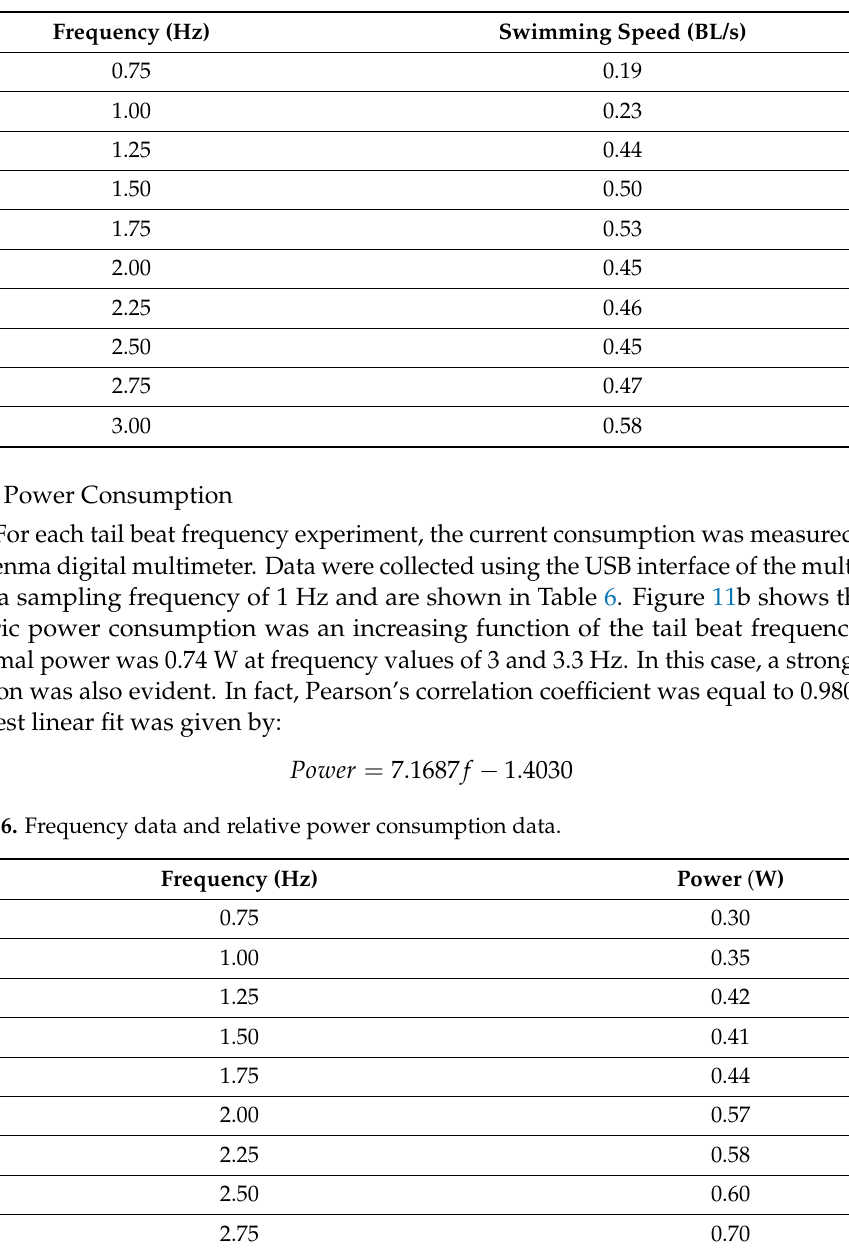
Table 5. Frequency data and relative swimming speed values.